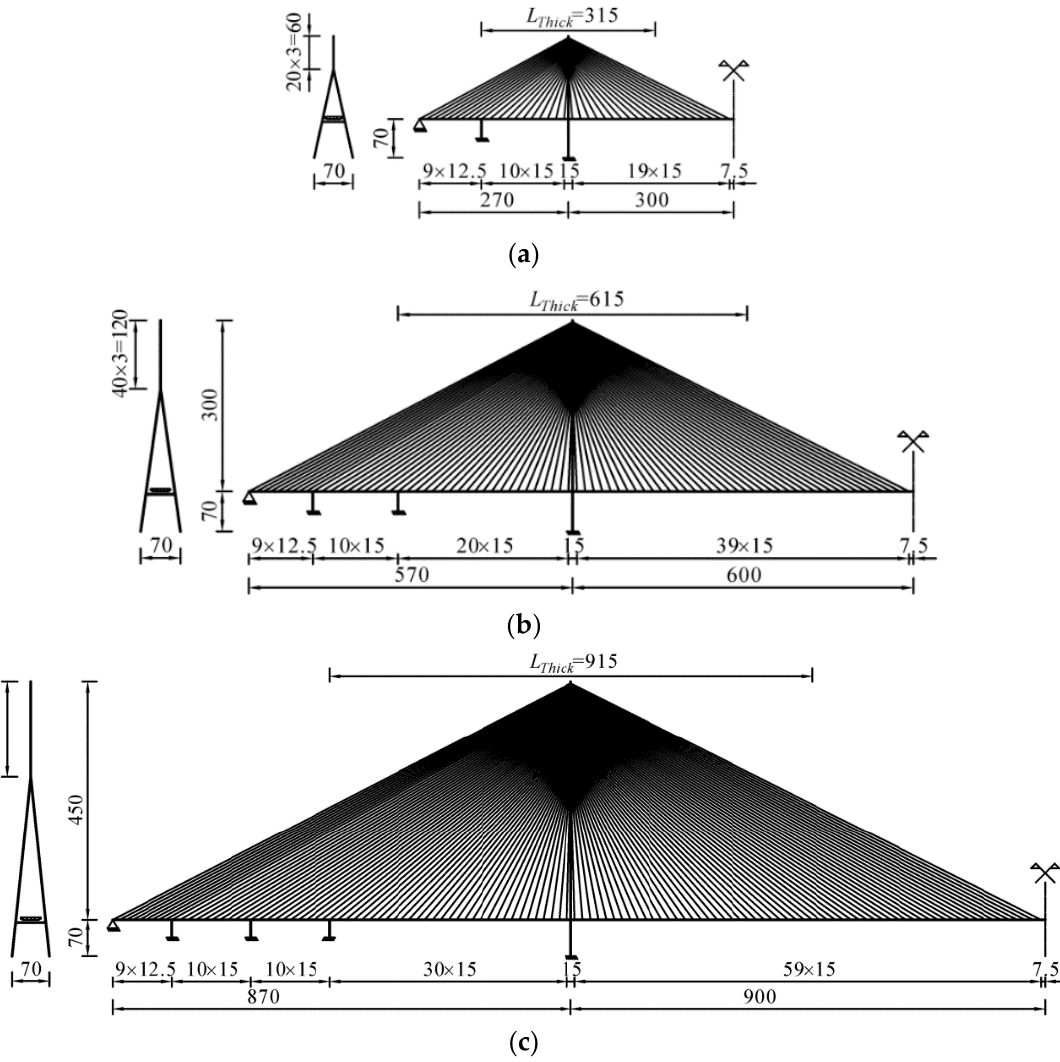
Figure 3. Overall layouts of the investigated cable-stayed bridges: ( a ) main span = 600 m; ( b ) main span = 1200 m; ( c ) main span = 1800 m.